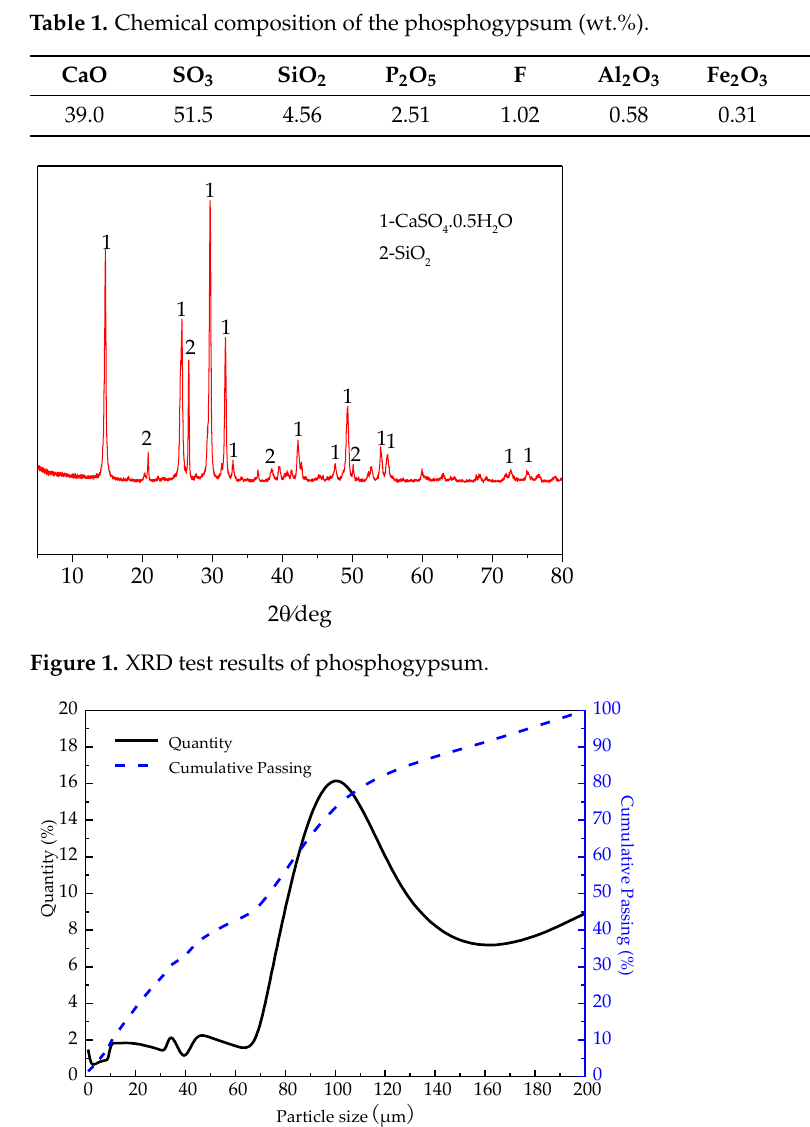
Figure 2. Particle size distribution of phosphogypsum raw materials.